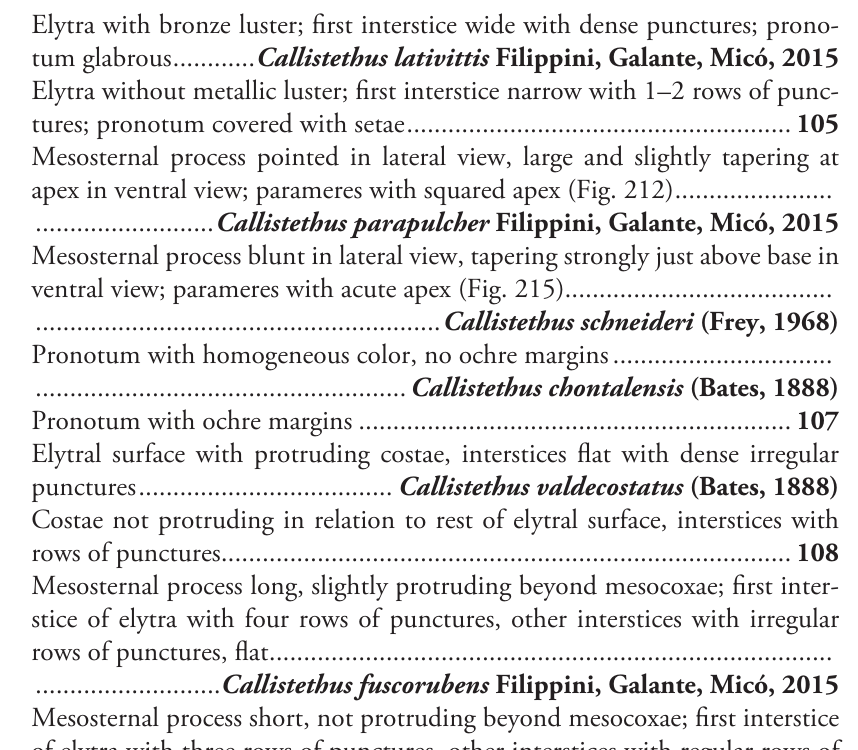
– Mesosternal process short, not protruding beyond mesocoxae; first interstice of elytra with three rows of punctures, other interstices with regular rows of punctures forming sulcate striae ............................................................. 109 109 Secondary small sparse punctures on the whole elytra surface; aedeagus Fig. 203; endophallus Fig. 313 ............ Callistethus granulipygus (Bates, 1888) – No secondary punctures on elytra, background surface smooth; aedeagus Fig. 220; endophallus Fig. 330 ............... Callistethus vanpatteni (Bates, 1888) 110 – Elytra nearly smooth with very shallow rows of punctures, black color ........ 111 Body length > 9.5 mm; pygidium ochre with green sides; head small in rela- tion to pronotum (head width < 0.45 pronotum width) .............................. – Body length < 8.6 mm; pygidium entirely yellow; head large in relation to pronotum (head width > 0.55 of pronotum width) ...................................... 112 Elytra surface with regular and sulcate striae, normally 14 in number .... 113 – Elytra surface nearly smooth, or with intercostal spaces with shallow